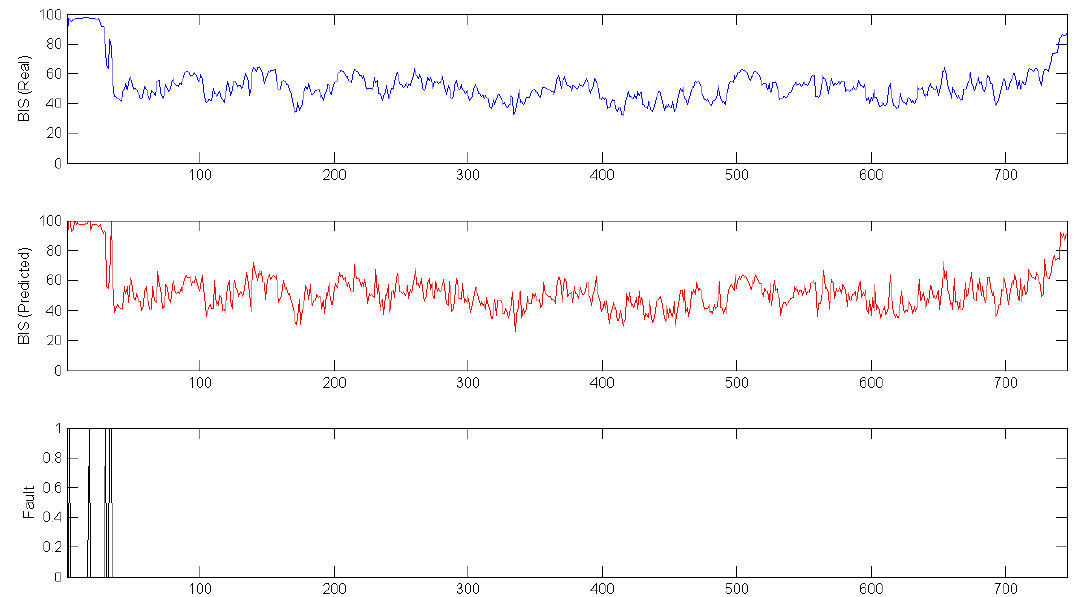
Figure 9. Real ( Top ); Predicted ( Middle ); and Fault ( Bottom ) Complete surgery with fault detection Range of